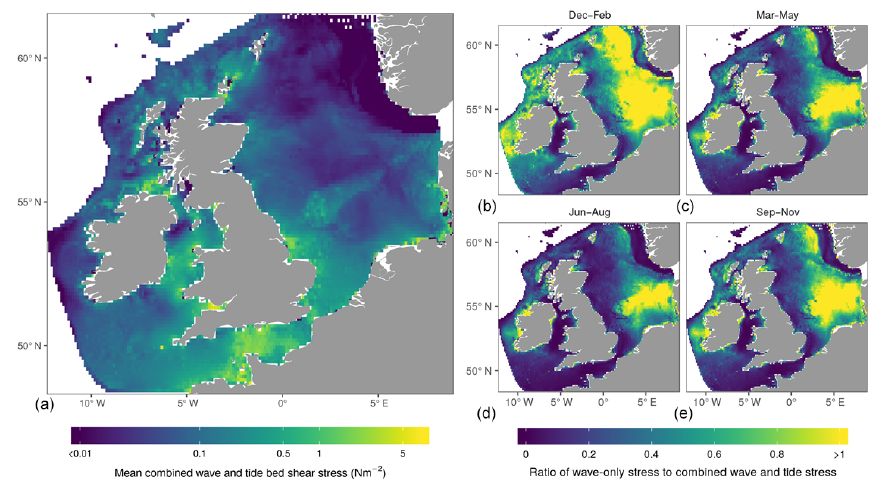
Figure 3. (a) Annual mean of combined wave and tide bed shear stress for 1997–2017. (b–e) Ratio of mean wave-only stress to combined wave and tide stress. Regions with high ratios are wave-dominated, whereas regions with low ratios are tide-dominated. Bed shear stress was calculated using the equations of Soulsby and Clarke (2005), tidal inputs from the Scottish Shelf Model and wave inputs from the ERA-Interim